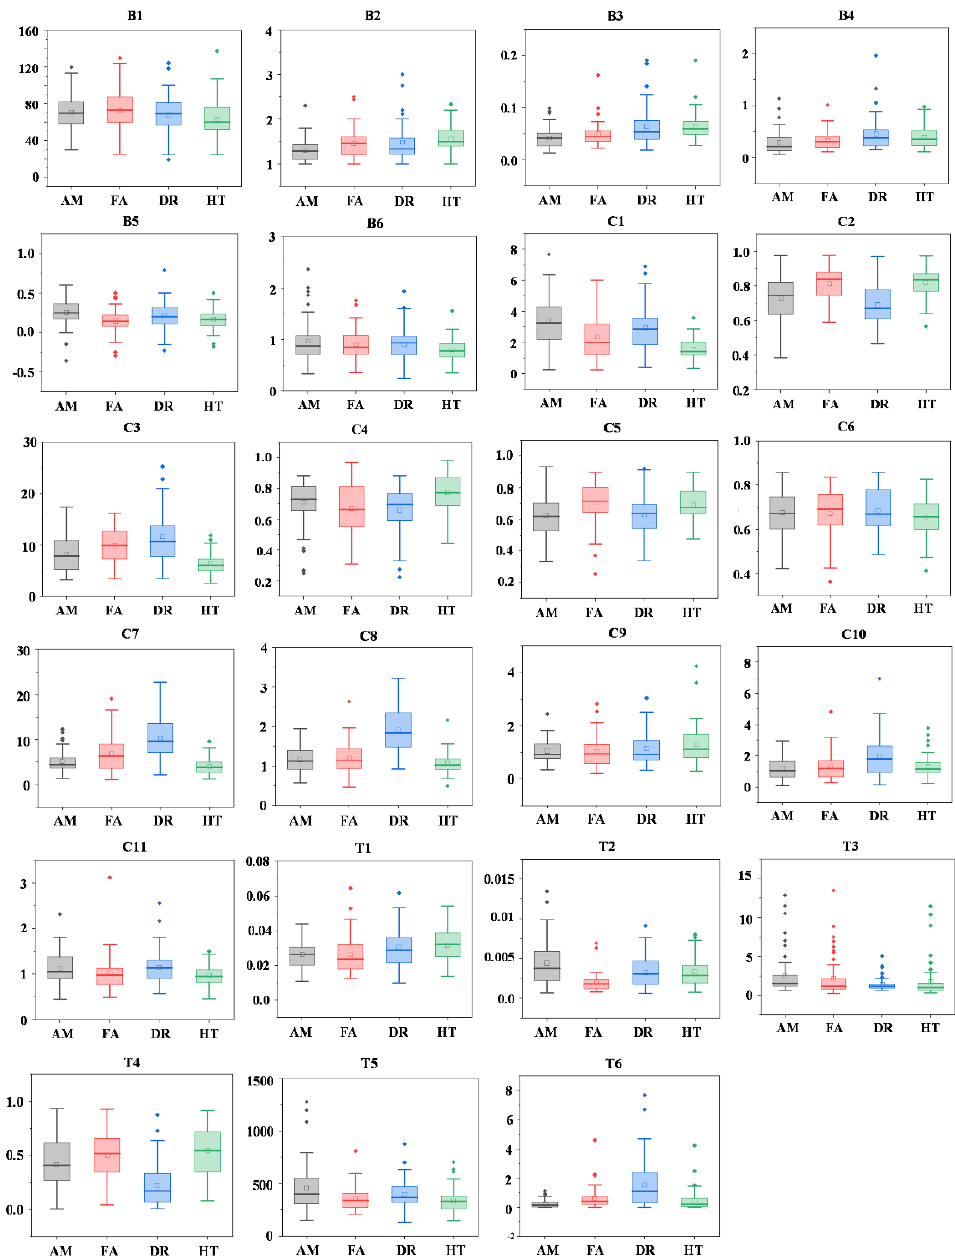
Figure 6. Boxplot of all structural parameter values of four selected species. The individual points out of the box are the outliers of each parameter of each species. The horizontal lines below and above the box are the minimum and maximum values excluding outliers, respectively. The bottom line and top line of the box are the median values of the lower half and upper half of the parameter of each species, respectively. The bold line and square in each box are the median and mean value of each parameter of each species, respectively.